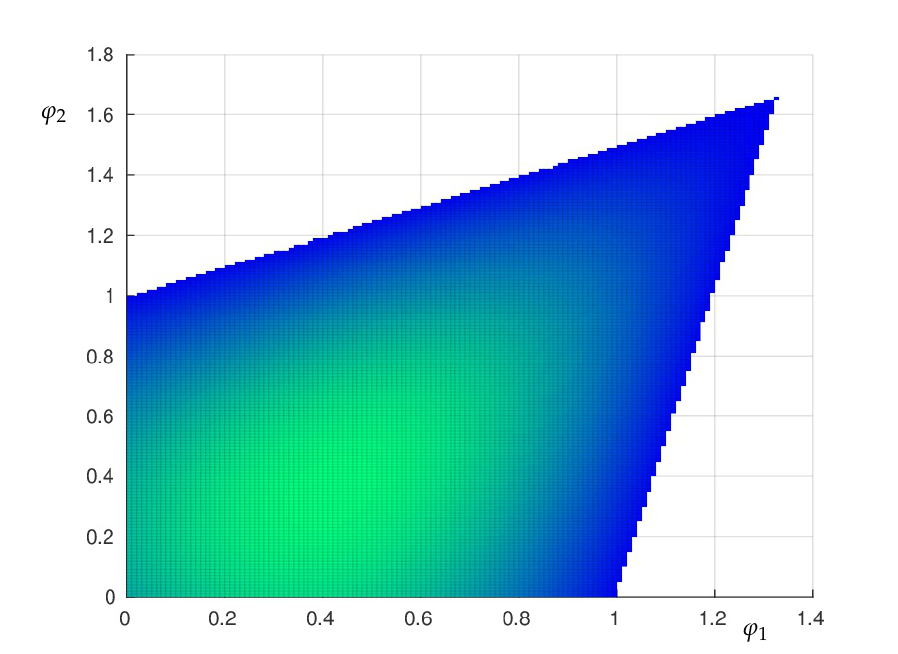
Figure 5. The Terminal Wealth Relative from Figure 4, view from